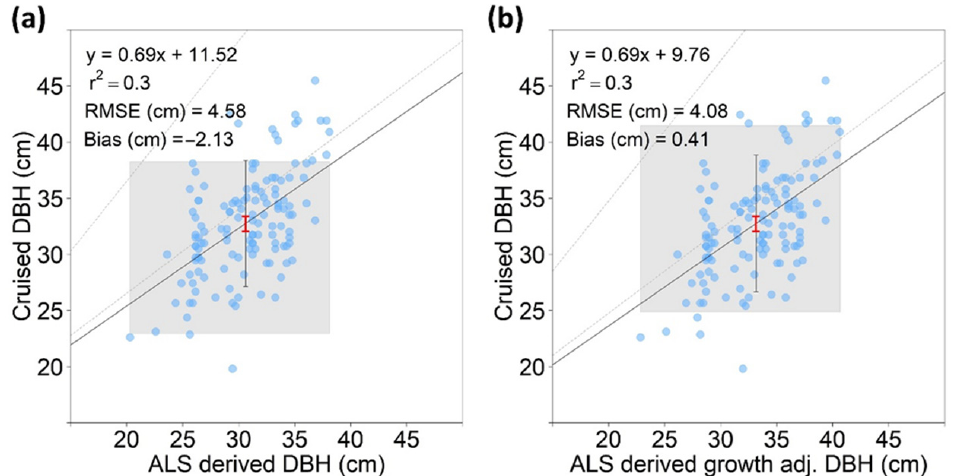
Figure 6. Equivalence test graphs for cruised tree DBH versus ( a ) ALS-derived DBH and ( b ) ALS-derived growth-adjusted DBH. The grey polygon represents the ± 25% region of equivalence for the intercept. The ALS-derived DBH is equivalent to the cruised DBH when the vertical red bar is completely within the grey polygon. The grey dashed lines represent the ±25% region of equivalence for the slope. If the vertical black bar is within the grey dashed lines, then the regression slope is significantly similar to 1. The solid black line represents the best-fit linear regression model.